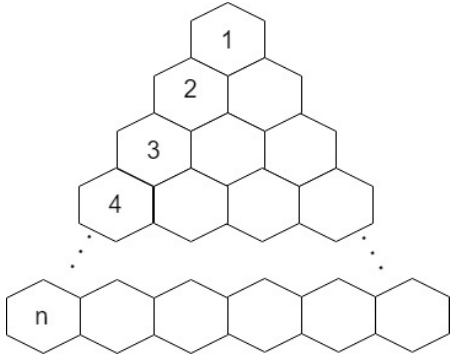
Figure 10. Molecular graph of triangular